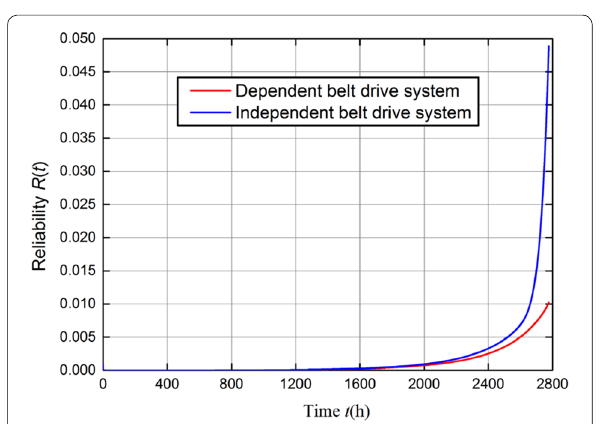
Figure 11 Failure rate of the belt drive